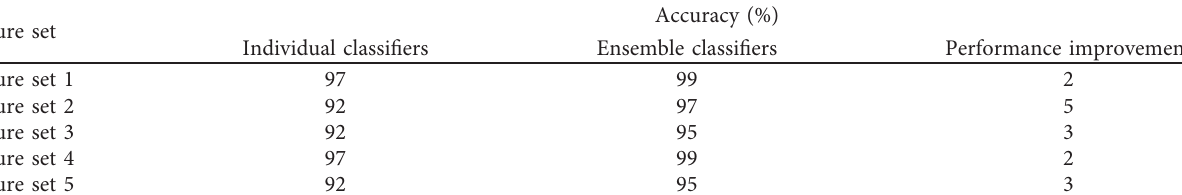
Table 9: The performance improvement between the ensemble-based classifiers with individual classifiers. Feature